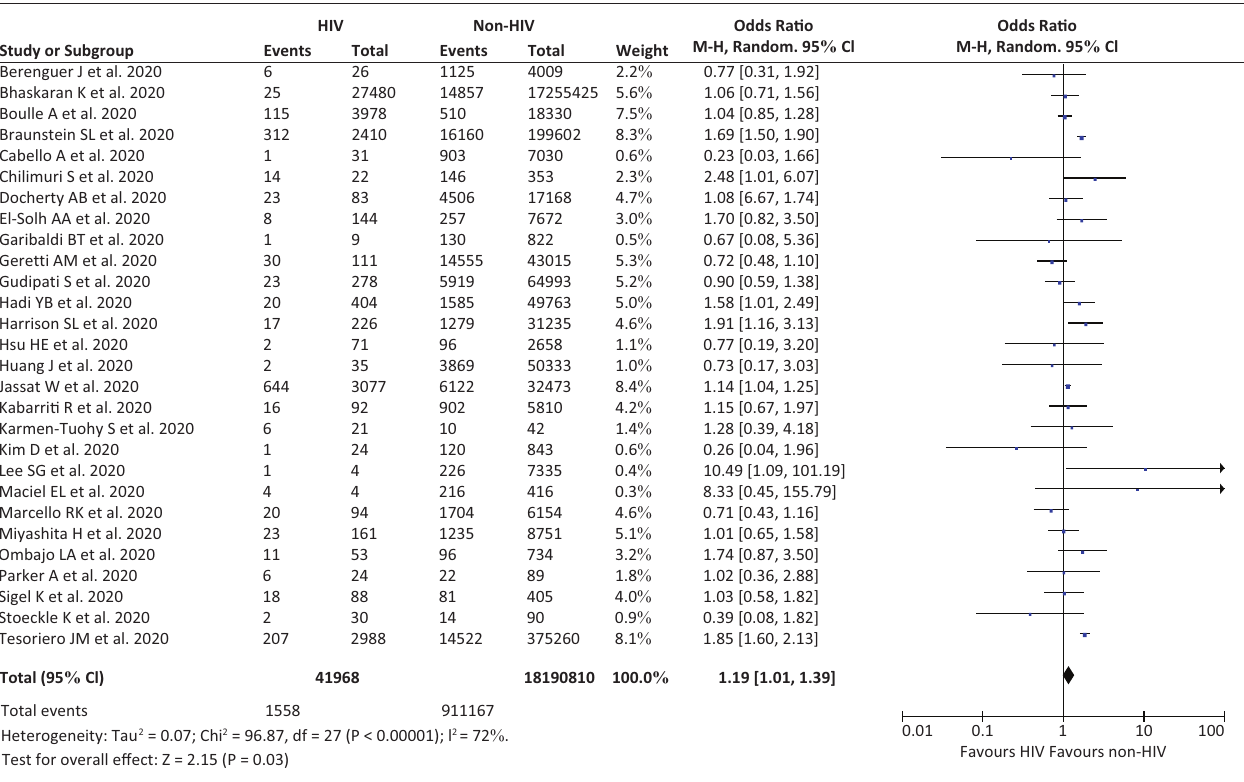
FIGURE 2: Forest plot that demonstrates the association of HIV with mortality from COVID-19